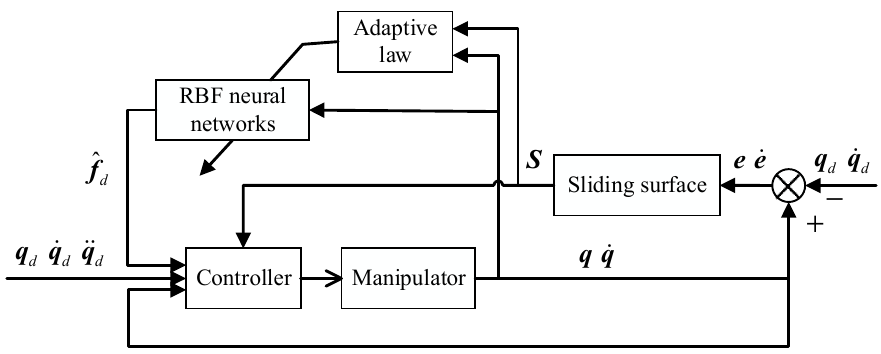
Figure 3. The structure of the ANTSM control using RBFNN.